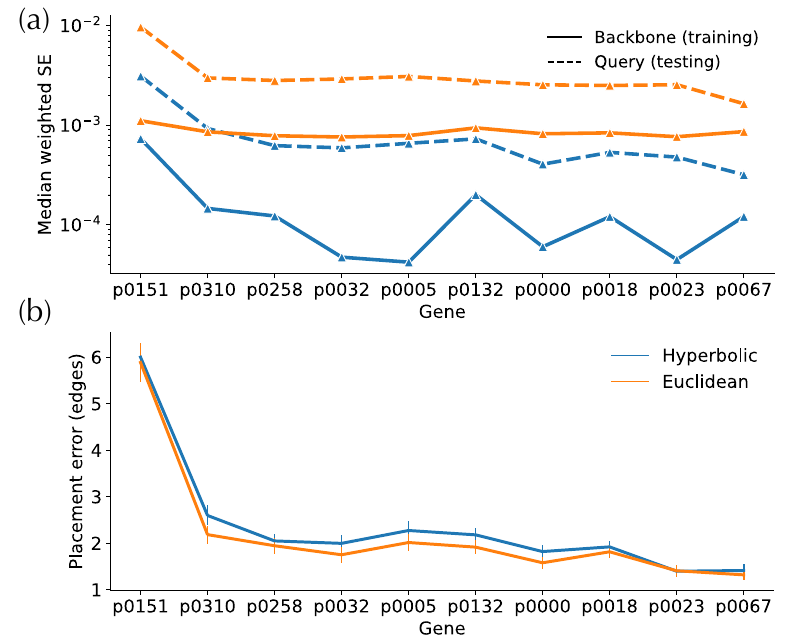
Figure A1. Comparison of Hyperbolic and Euclidean embeddings in WoL marker genes data. ( a ) Median square error of embedding distances. ( b ) Placement